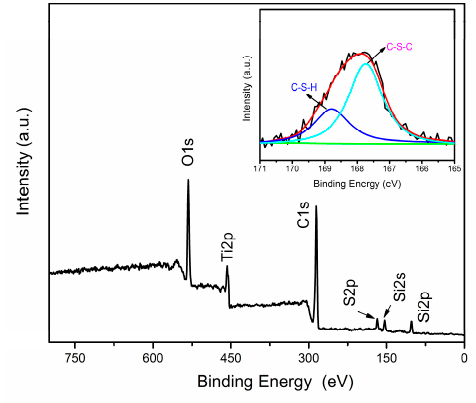
Figure 5. X-ray photoelectron spectroscopy (XPS) spectrum and S2p high-resolution spectrum of TiO 2 -HBP.